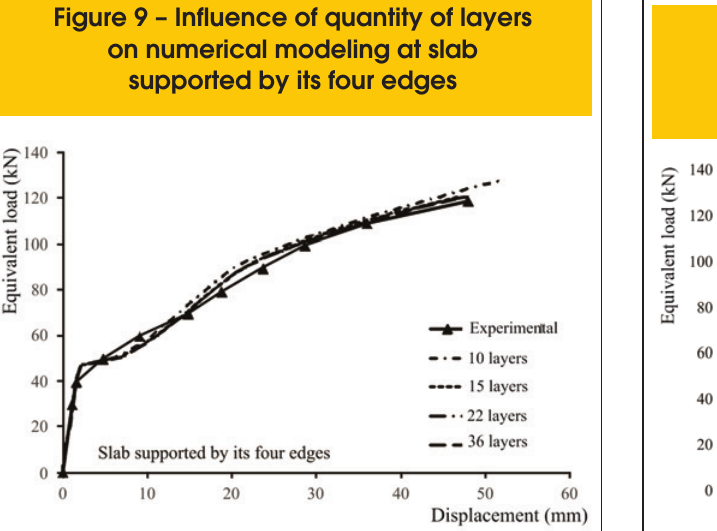
Figure 10 – Comparison between experimental, proposed model and FEM